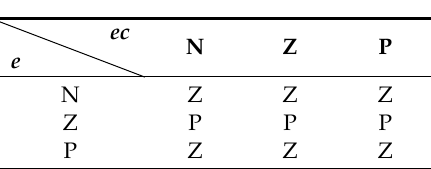
Table 2. Fuzzy rules of k I .